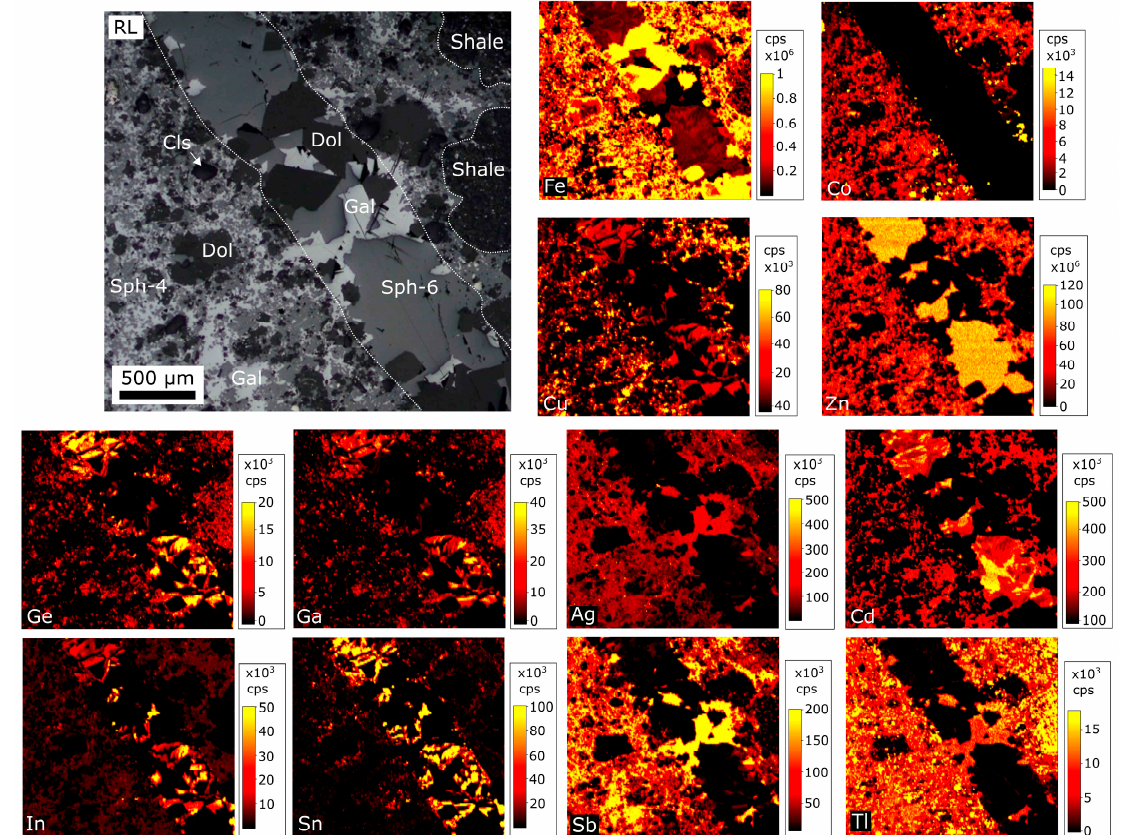
Figure 9. LA-ICP-MS trace element maps across a sample containing sph-4 and a ferroan-dolomite vein containing sph-6. The trace element maps indicate that sph-6 is enriched in Zn, Ge, Ga, Cd, In and Sn, and depleted in Fe, Co, Ag, Sb and Tl relative to sph-4. It is also seen that sph-6 is zoned in the elements Cu, Ge, Ga, Cd, In and Sn. All trace element maps are in counts per second (cps).